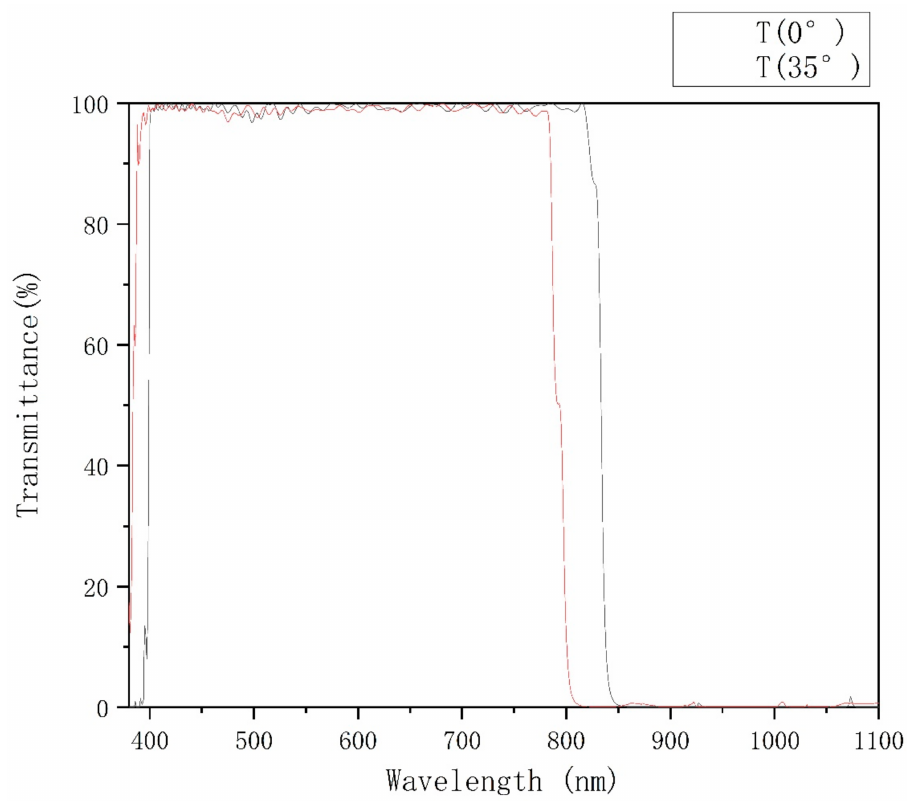
Figure 2. Design Spectral to 0 ◦ and 35 ◦